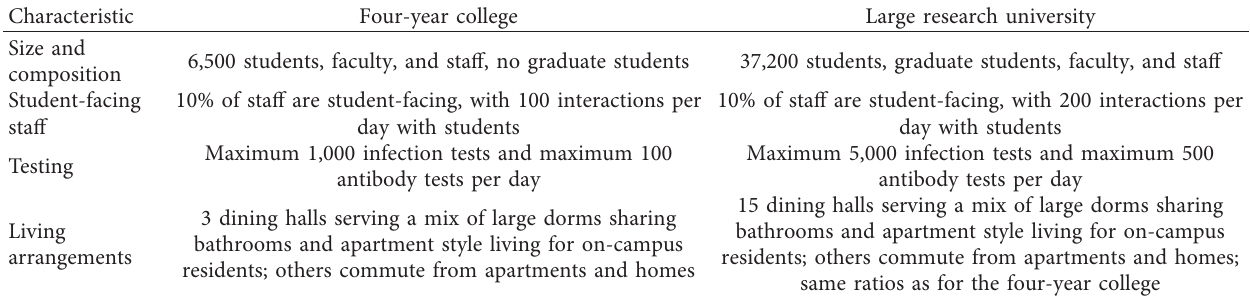
Table 1: Basic characteristics of the two types of universities